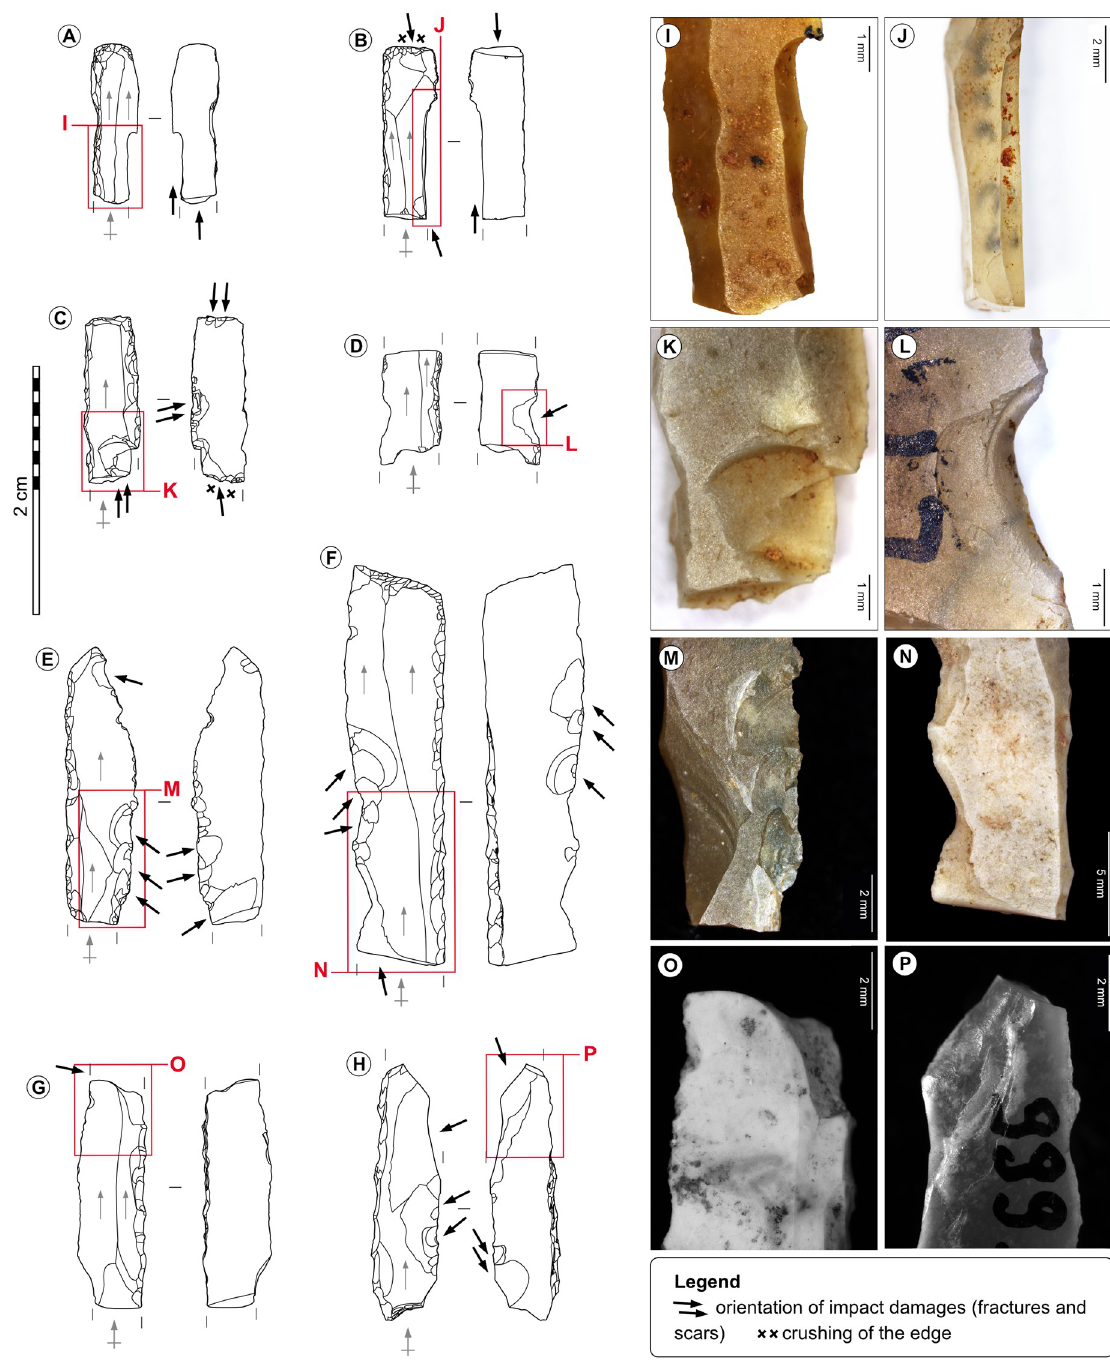
Fig 14. Impacted backed bladelets. A-Truncated simple backed bladelet from the Blanchard cave, layer B2. B-Double backed bladelet from the Blanchard cave, layer B4. C-Truncated double backed bladelet from the Blanchard cave, layer B3. D-Simple backed bladelet from the Blanchard cave, layer B5. E, G-Simple backed bladelet from La Marche. F, H-Truncated simple backed bladelet from La Marche. I-Burin- like spin-off fracture on tool n˚A. J-Burin-like spin-off fracture on tool n˚B. K-Facial spin-off fracture on tool n˚C. L-Large isolated impact scar on tool n˚D, credits: Gauvrit Roux, 2019. M-Large overlapped impact scars on tool n˚E. N-Twisted bending fracture on tool n˚F. O-Burin-like fracture on tool n˚G. P-Oblique bending fracture interrupted by a snap fracture on tool n˚ H.